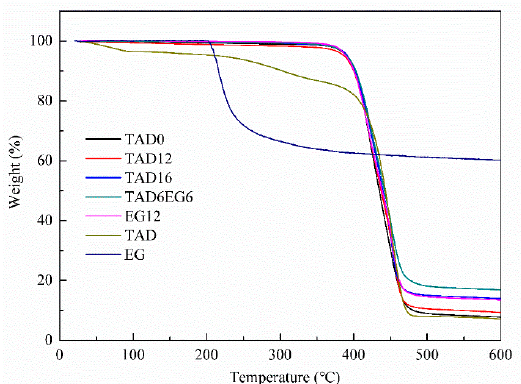
Table 3. Thermal parameters of PBT/PET blend and flame-retardant PBT/PET blends.